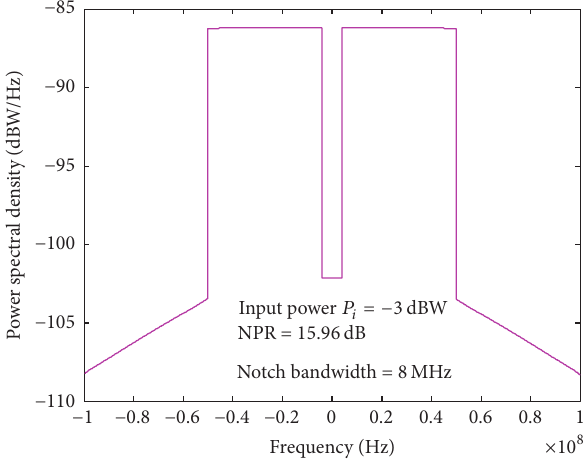
Figure 10: Amplifier output noise power spectral density with 𝑃 𝑖 = −3 dBW, 𝐵 notch = 8 MHz, and notch depth = 80dB.